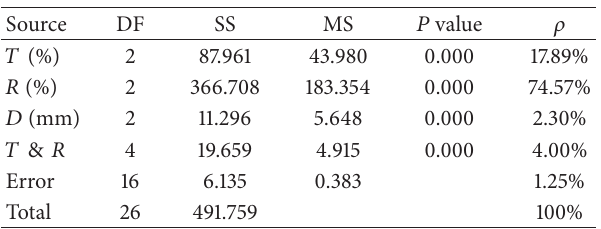
Figure 6: Test box configuration for the indoor bifacial BIPV panel with an integrated reflector. Table 3: Analysis of